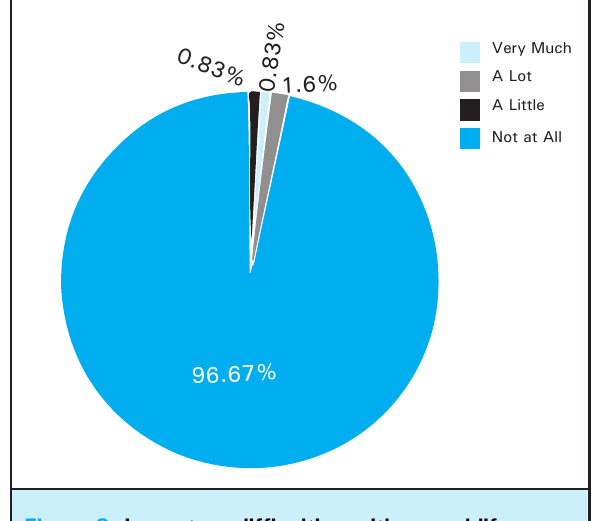
Figure 3. Impact on difficulties with sexual